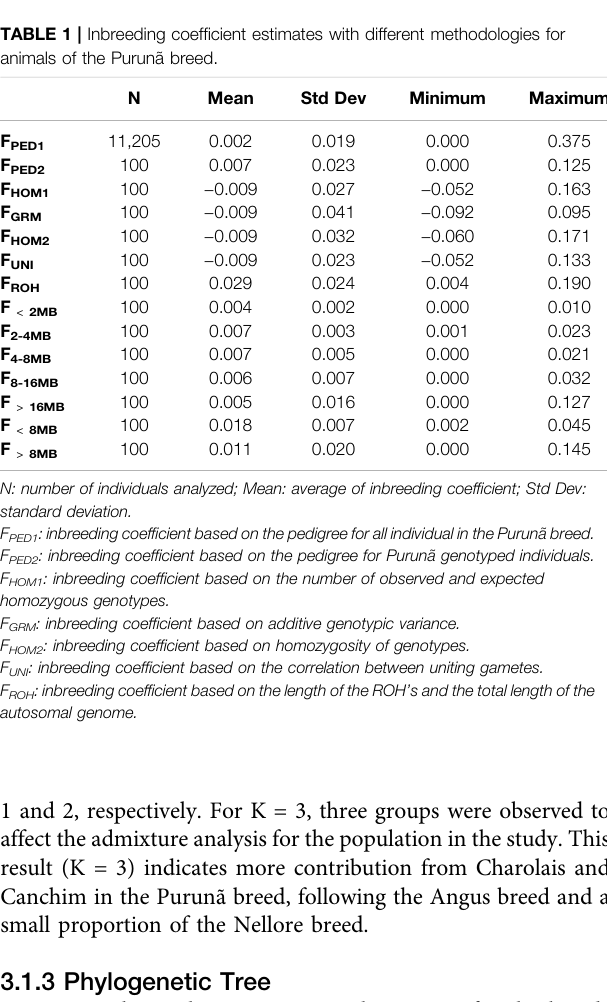
TABLE 1 | Inbreeding coef fi cient estimates with different methodologies for animals of the Purunã breed. N Std Dev